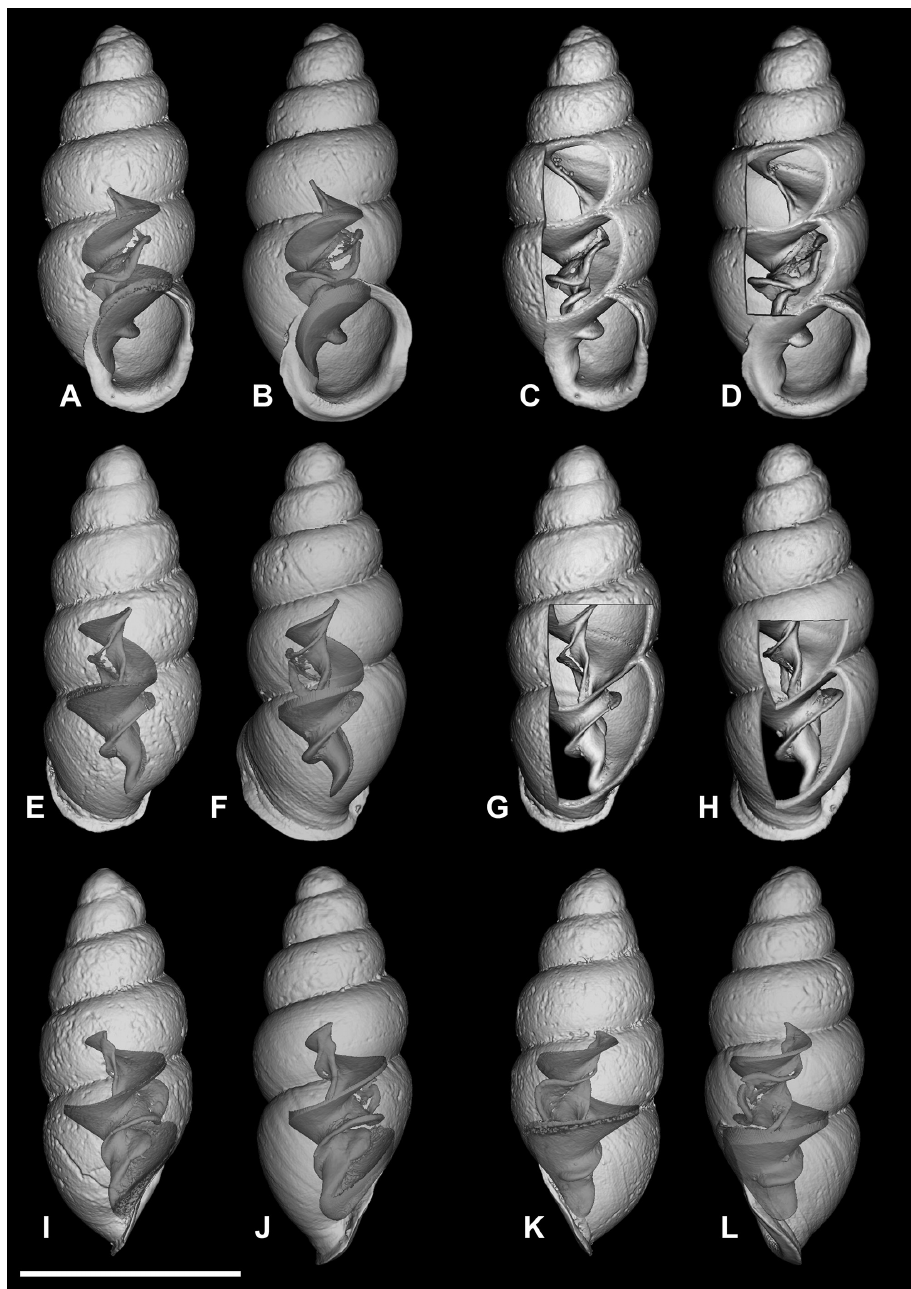
Figure 12. Carychium belizeense sp. n. A–L CT scans showing columellar apparatus of paratype (NMBE 549924/8) C–D two-tiered, tightly coiled columellar lamella and prominent parietal denticle I–J highly sinuate tongue-like primary lamella tightly arching over swollen secondary lamella. Scale bar 1